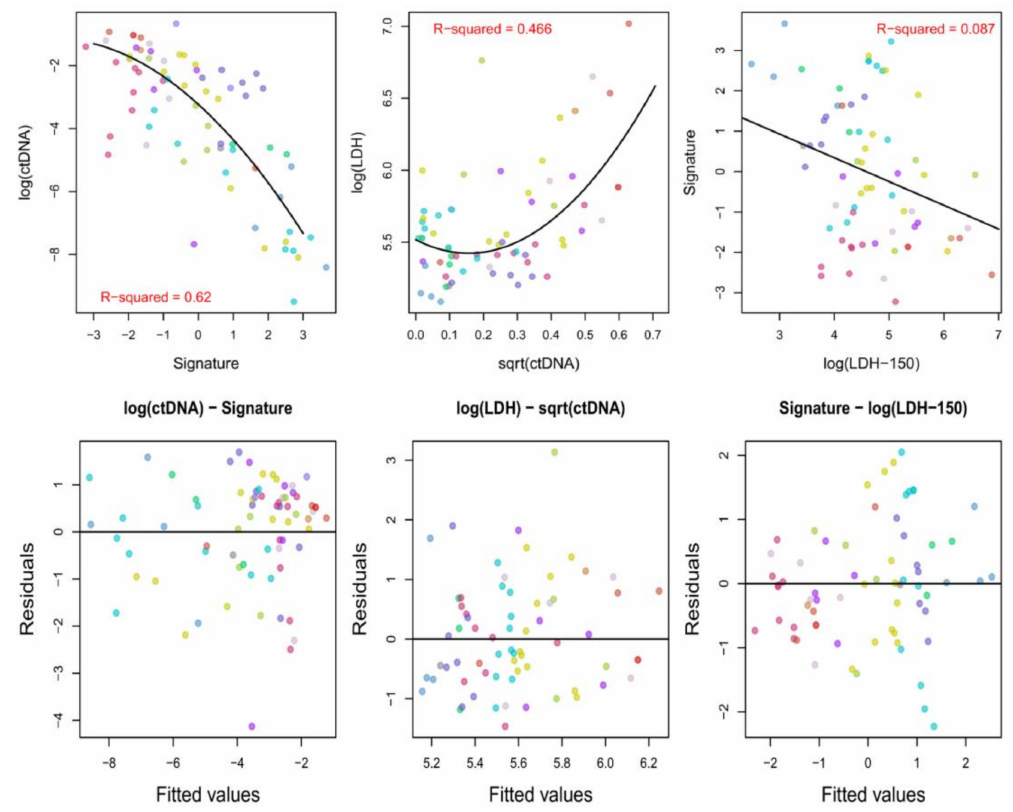
Figure 5. The interrelationship between log(ctDNA maf ), serum LDH, and the radiomics signature in Equation (1). The three upper plots show the relationships between the radiomics signature and measured ctDNA maf ( upper left ); ctDNA maf and the measured LDH concentration (in UL − 1 , upper middle ); LDH concentration and the radiomics signature ( upper right ), color-coded by patient. The variables are transformed in a way that yields the best fitting model in each case. The solid lines show the estimated mean values of the outcomes of interest at the population level as a function of their predictors, as fitted by means of random intercept mixed models. The three lower plots show the standardized residuals on the y -axes vs. the fitted values from the random intercept models used to assess the level of association between ctDNA maf , LDH concentrations and the PCA-based signature, color-coded by patient. The upper plots show a strong relationship between the radiomics signature and ctDNA maf , and also between LDH and ctDNA maf , but importantly there is no strong relationship between the radiomics signature and LDH: although the radiomics signature and LDH are both associated with ctDNA maf they are complementary. Note that ‘log’ denotes the natural